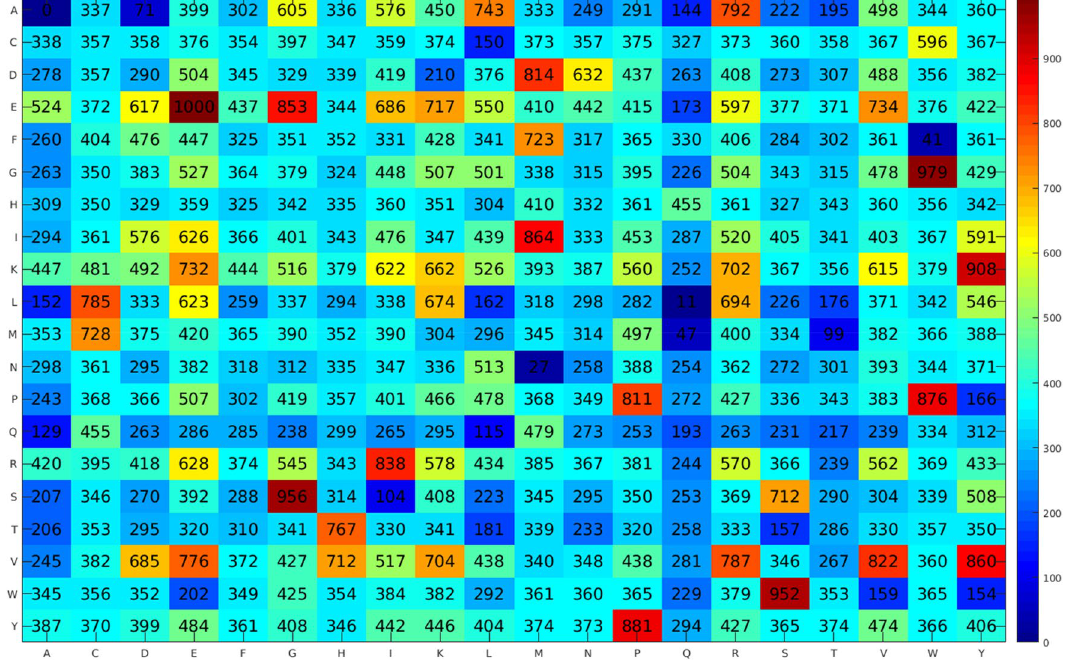
Figure 2. Propensity scores of 400 dipeptides as obtained from the proposed SCMTPP.